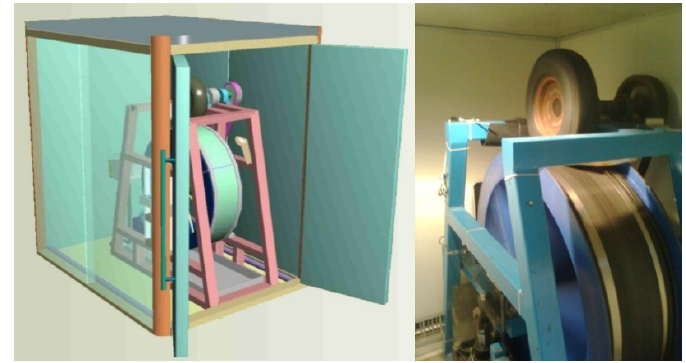
Figure 1. The Driving Wheel Pavement Analyzer (DWPA) test system.